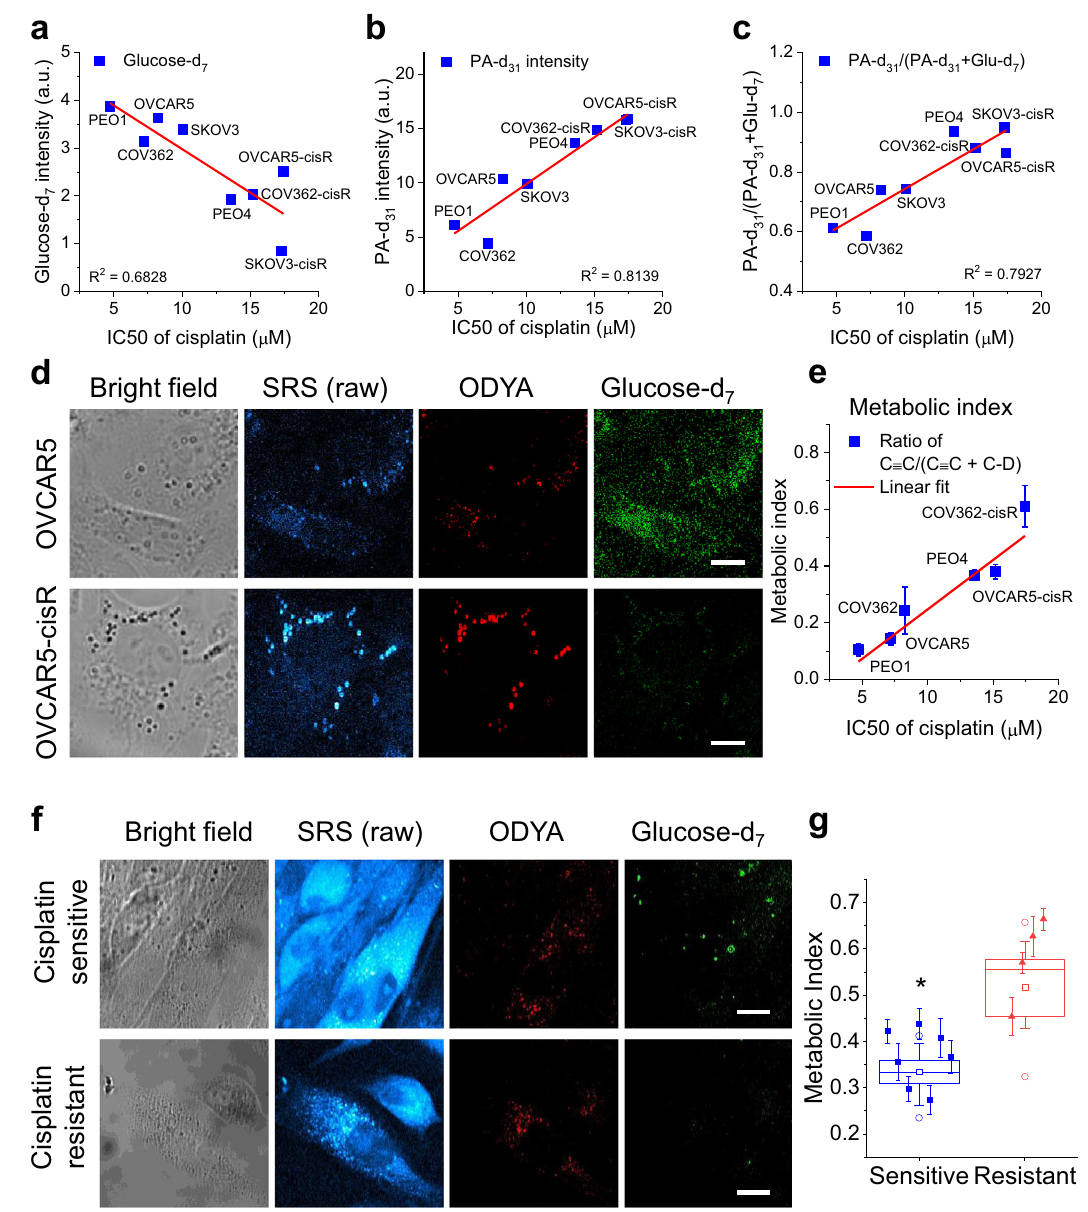
Fig. 3 | Metabolic index by integrating glucose-derived lipogenesis and FA uptake directly correlates with cisplatin resistance. a A linear regression of glucose-d 7 intensity to IC 50 s of cisplatin in various OC cell lines. b A linear regres- sion of PA-d 31 intensity to IC 50 s of cisplatin in various OC cell lines. c A linear regressionoftheratioofPA-d 31 /(PA-d 31 +Glucose-d 7 )toIC 50 sofcisplatininvarious OC cell lines. n =6 technical replicates for ( a – c ). d Representative bright fi eld images, raw SRS images, and processed SRS images of ODYA and glucose-d 7 in OVCAR5 and -cisR cells. e A linear regression of the metabolic index, as de fi ned by the ratio of C ≡ C/(C ≡ C+C-D) to IC 50 s of cisplatin in various OC cell line pairs (COV362 ( n =8), PEO ( n =6 and 7) and OVCAR5 ( n =4)). n represents technical replicates. R 2 =0.9235. Data is shown as mean±SEM. f Representative bright fi eld images, raw SRS images, and processed SRS images of ODYA and glucose-d 7 in